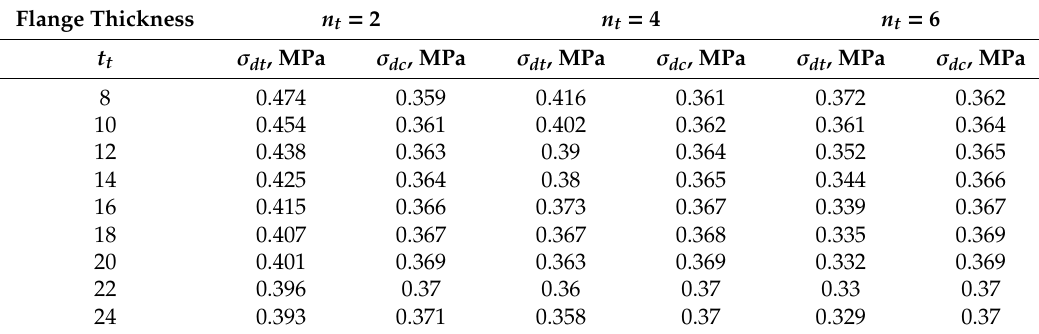
Figure 9. Dependences of the dynamic normal stresses on the thickness of the flange t t of the I-beam and the number of reinforcement rods in the tension zone of the fiber-reinforced concrete beam, taking into account the beam mass and bimodularity at n c = 2, E c = 2250 MPa, E t = 5000 MPa: ( 1 ) dynamic tensile stresses at n t = 2; ( 2 ) dynamic compressive stress at n t = 2; ( 3 ) dynamic tensile stresses at n t = 4; ( 4 ) dynamic compressive stress at n t = 4; ( 5 ) dynamic tensile stresses at n t = 6; ( 6 ) dynamic compressive stresses at n t = 6. Table 8. Dependences of dynamic normal stresses on the thickness of the flange t t of the I-beam and the number of reinforcement bars in the tension zone of a fiber-reinforced concrete beam, taking into account the beam mass and bimodularity at n c =